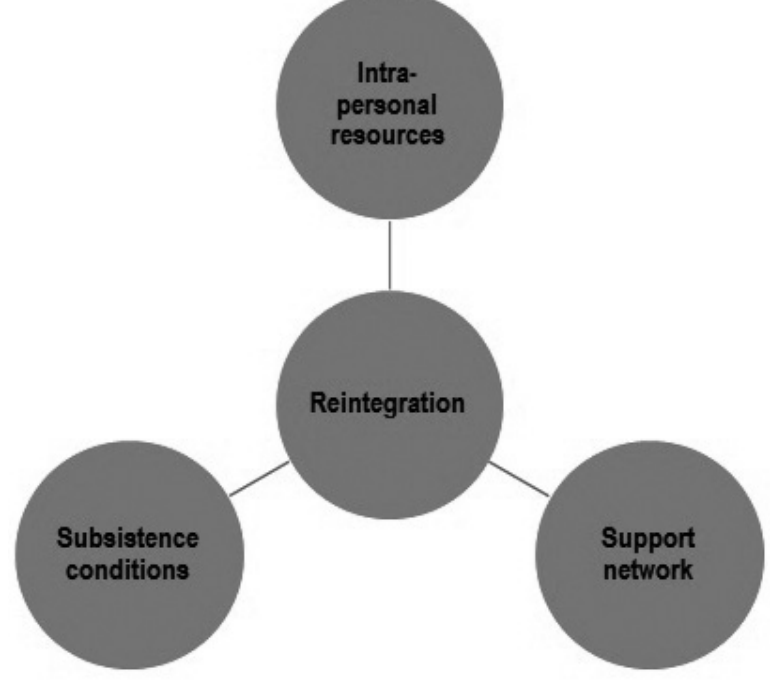
Figure 1: A simple, three-part model of